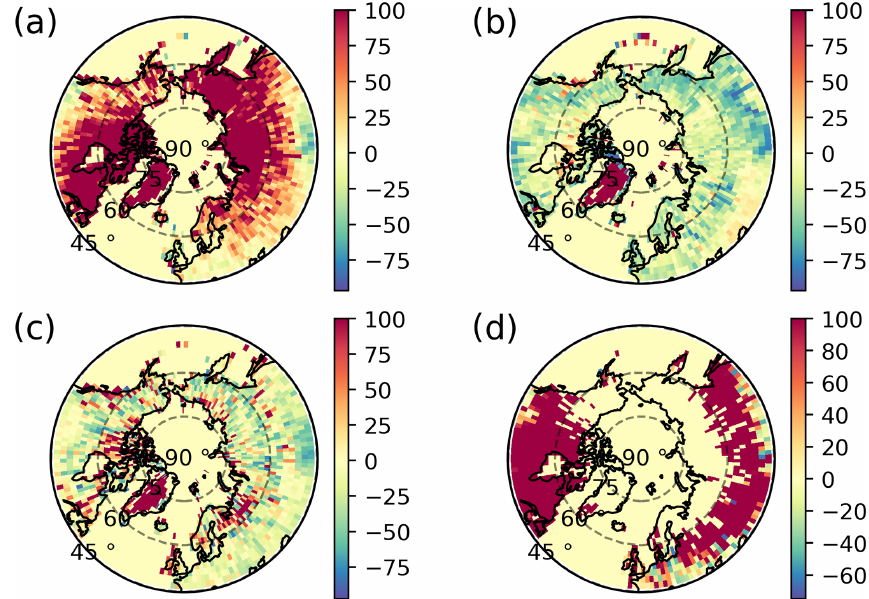
Figure 8. Polar plots of the percent difference in the number of soundings that pass the NN filter compared to the qc_flag filter for spring (a) , summer (b) , fall (c) , and winter (d) . The data have been binned by 2 ◦ longitude by 2 ◦